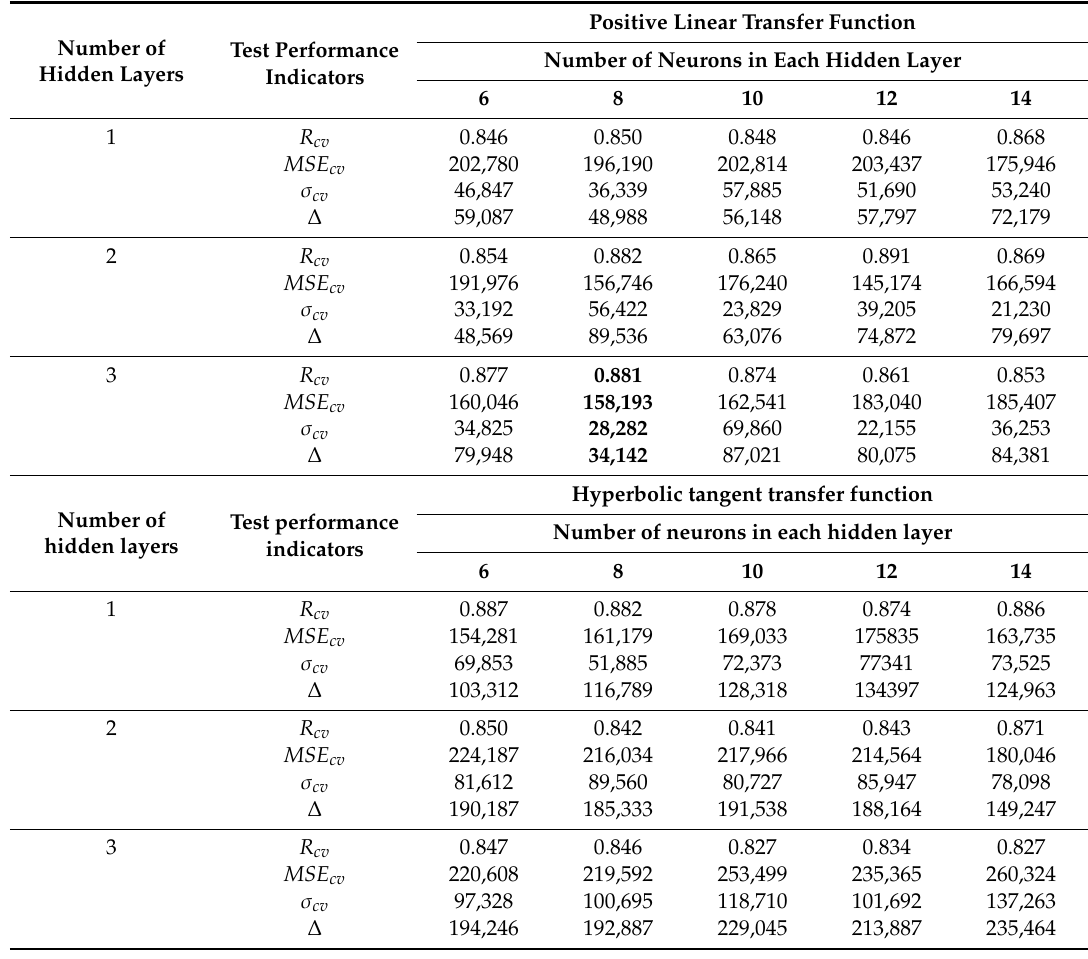
Table 4. Estimates of sti ff ness modulus models’ predictive performance by five-fold cross